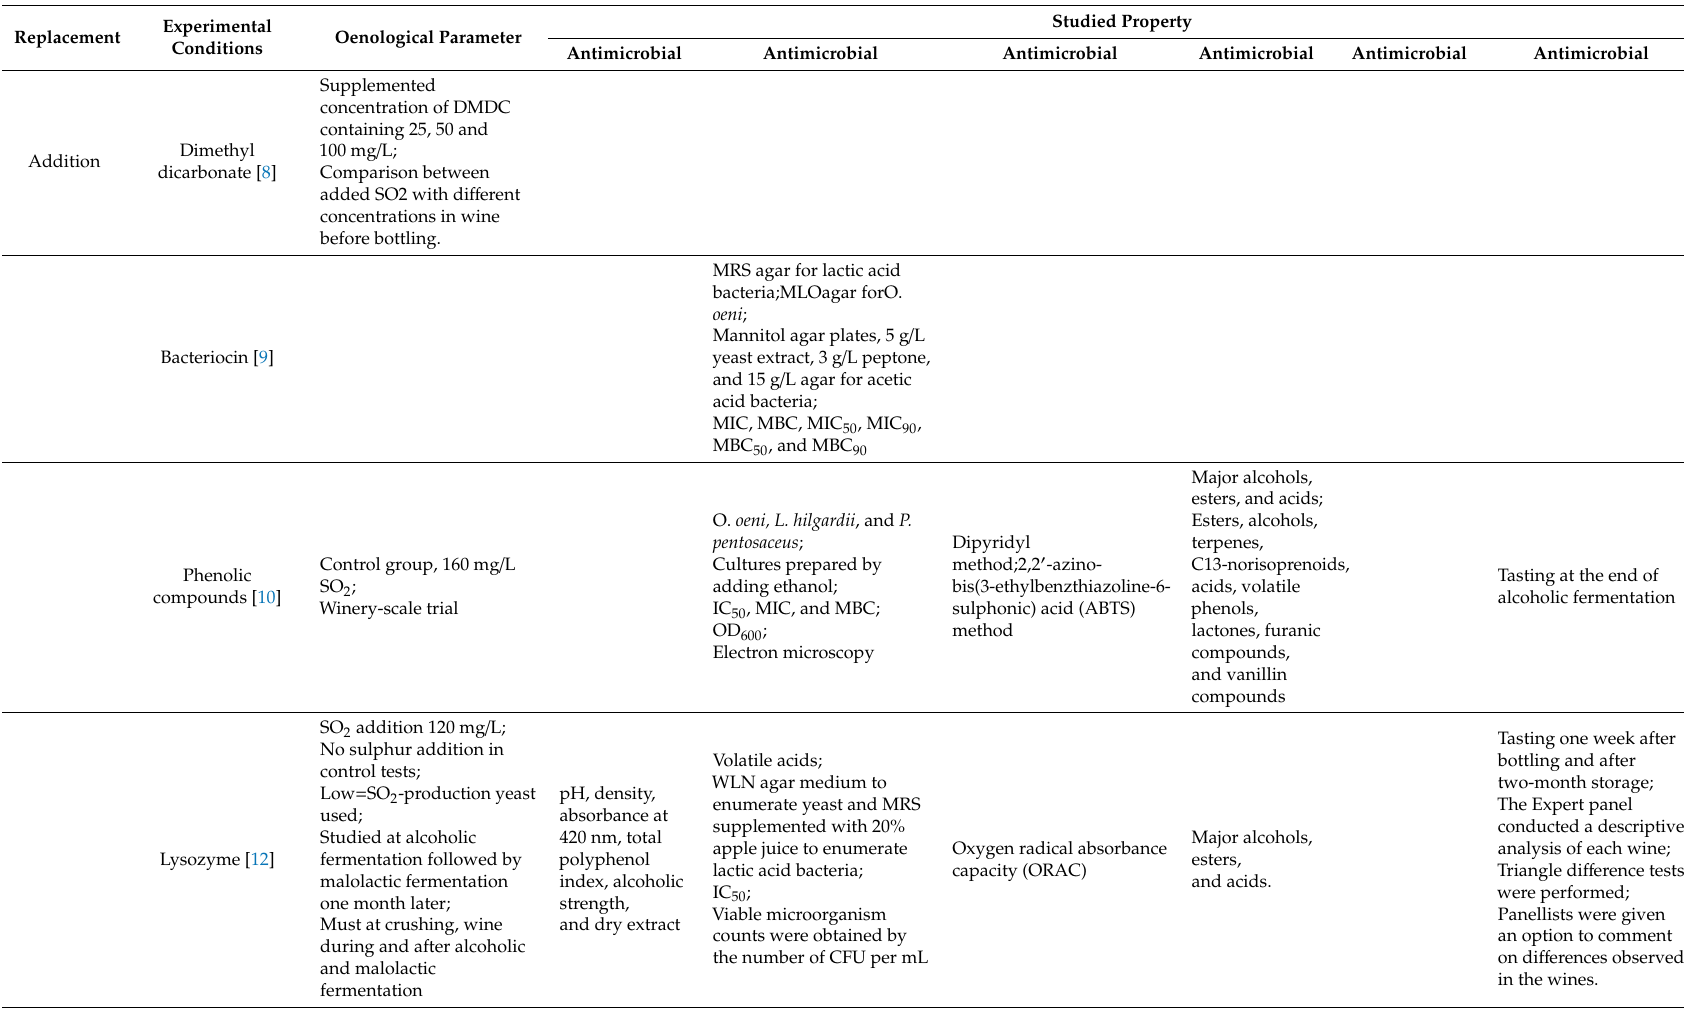
Table 5. Experimentally analyzed parameters when studying SO 2 replacement in wine. (referred to [34] with minor